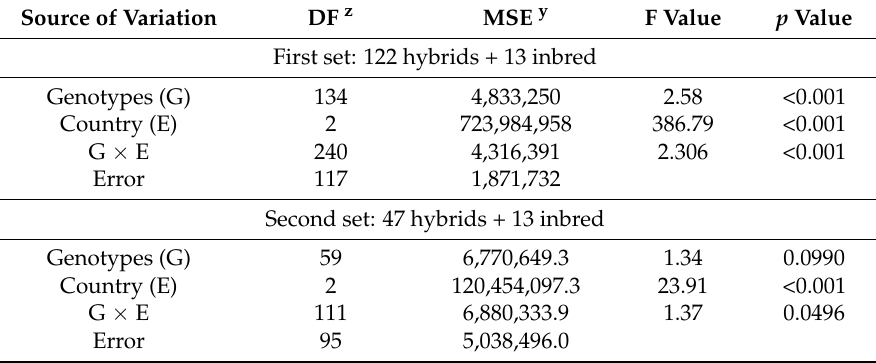
Table 1. Combined analysis of variance for grain yield of two sets of hybrids and their cultivar checks across sites in Mali, Nigeria, and